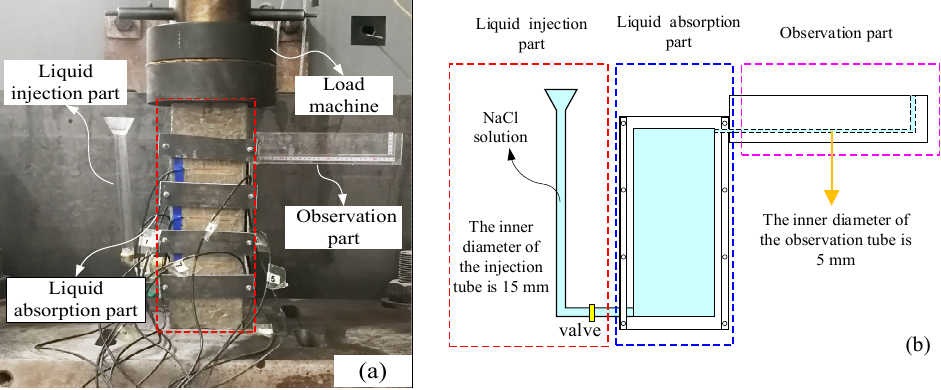
Figure 2. Schematic diagram of testing device: ( a ) test setup and ( b ) schematic diagram.